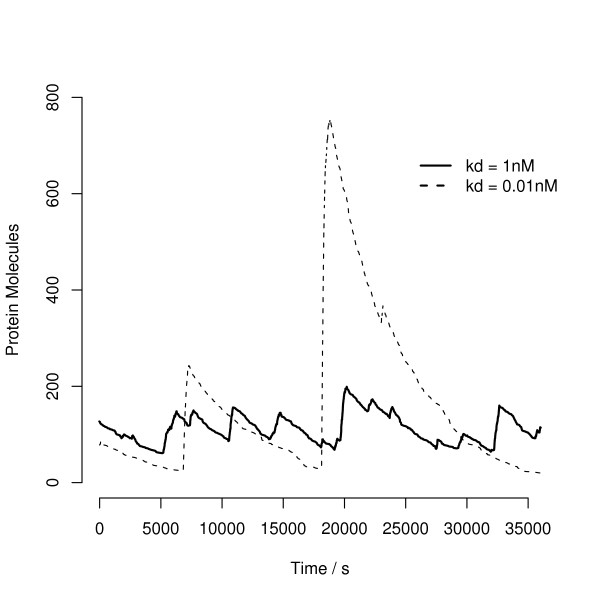
Bursty Protein Production. Two simulations contrasting the behaviour of protein abundance for a moderate repressor with kdof 1 nM (solid line) and a strong repressor with kd of 0.01 nM (dashed line). For the 1 nM repressor, all other parameters are as in Figure 1(a). For the strong repressor, km has been adjusted so that the both models have an average protein abundance of 100 molecules per cell – this allows both simulations to be plotted on the same axes so that the noise can be easily compared. In both cases, protein is produced in bursts. With the moderate repressor, the bursts are short and protein level is being continuously adjusted about the mean. With a strong repressor (low kd), the bursts are large and coincident with small number of times in this simulation that mRNA is synthesized. This is the source of the additional variability over and above the linearized system. It is also important to observe that the variability in protein abundance – at least for a stable protein – is slow relative to the cell cycle time. This means that extrinsic noise due to DNA and cell replication are likely to contribute very significantly to strongly auto-repressing transcription factors.